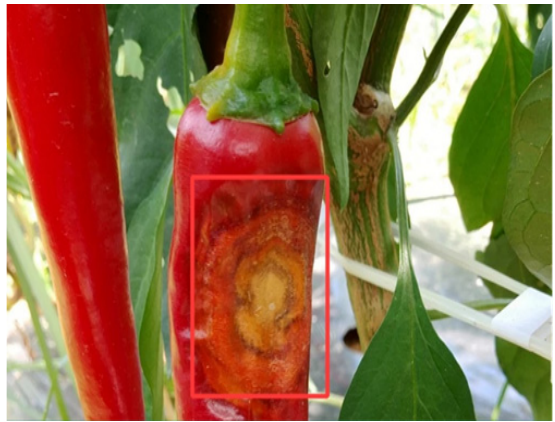
Figure 16. The red pepper with Anthracnose.